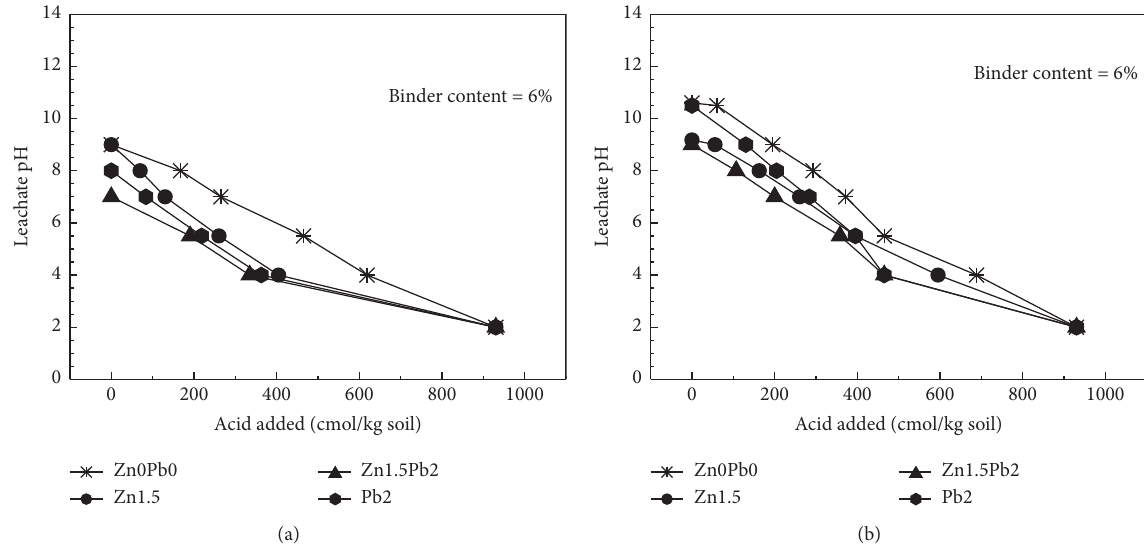
Figure 1: pH-acid titration curves of the stabilized clean and contaminated soils cured for 28 d: (a) KMP binder; (b) PC binder.